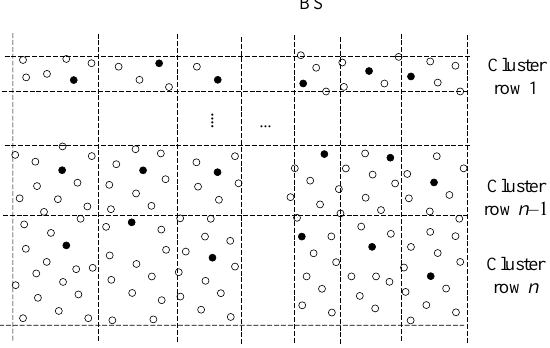
Figure 2. Potential unequal grid partitioning of a WSNs for future research